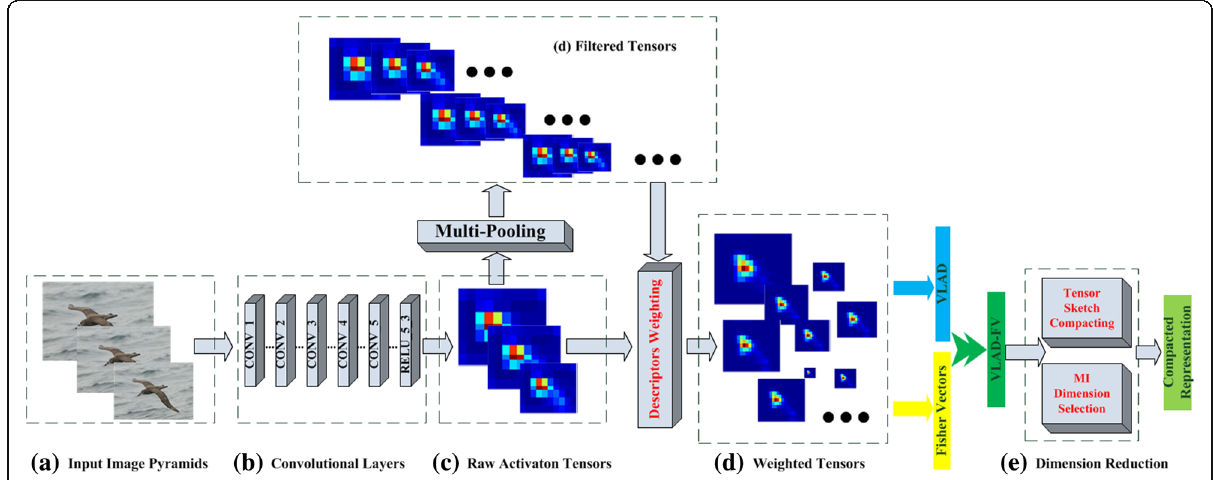
Fig. 1 An overview of our proposed feature extraction framework. VGG-16 [25] is used as the basic feature extractor. After rectified convolutional descriptors are extracted, they will be refined by a series of operations including multi-pooling, descriptors weighting, concatenation of two representations, and optional dimension reduction module. The panels in the figure refer to different modules in the proposed